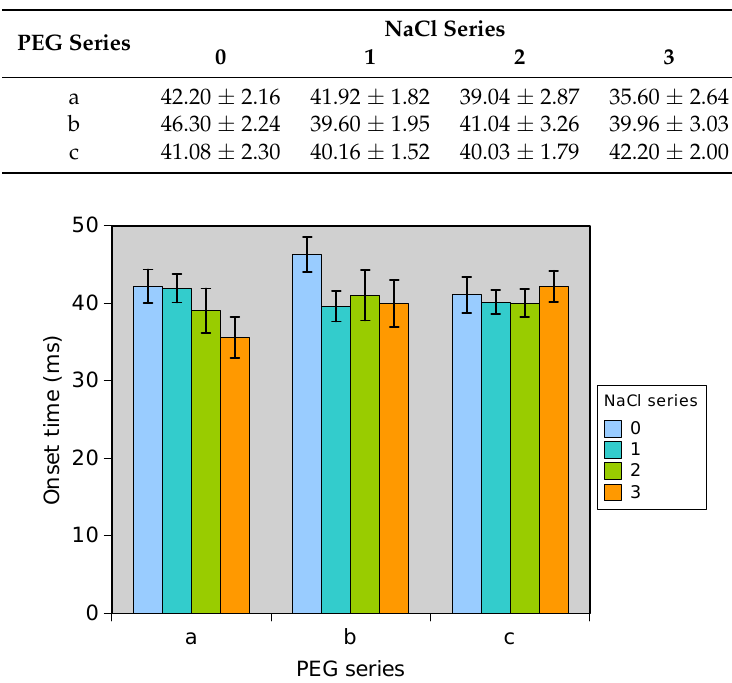
Table 11. The experimental instability onset times (ms) determined from oscilloscopic voltage–current delays. Mean values calculated from 10 measurements are given along with standard deviations of the mean. The air temperature was 24.0 ◦ C, and the relative humidity was 60%.